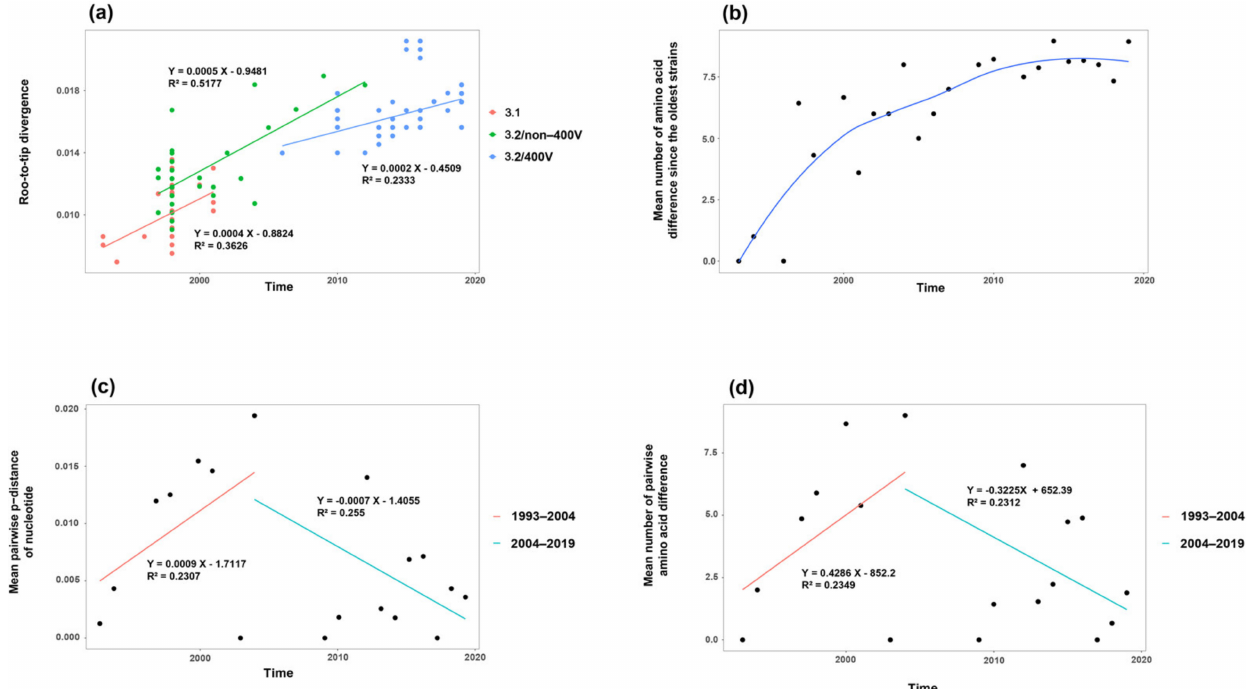
Figure 3. Time-evolutionary patterns of MeV genotype B3’s H gene. ( a ) Root-to-tip divergence plots; ( b ) mean number of amino acid differences since the oldest strains; ( c ) mean p -distance of nucleotides within strains collected in the same year; ( d ) mean number of amino acid differences within strains collected in the same